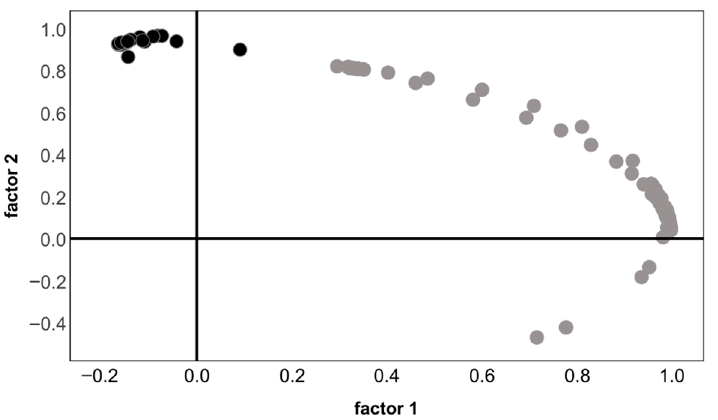
Figure 2. Principal component analysis of absorbance spectra of heads, hearts and tails fractions gained from distillates of mashes No. 1–10. Factor 1 explains 78.8% of the data variance. Factor 2 explains 16.4% of the data variance (cumulated = 95.2%). Wavelengths 230–310 nm (black), wavelengths 315–1000 nm (grey).